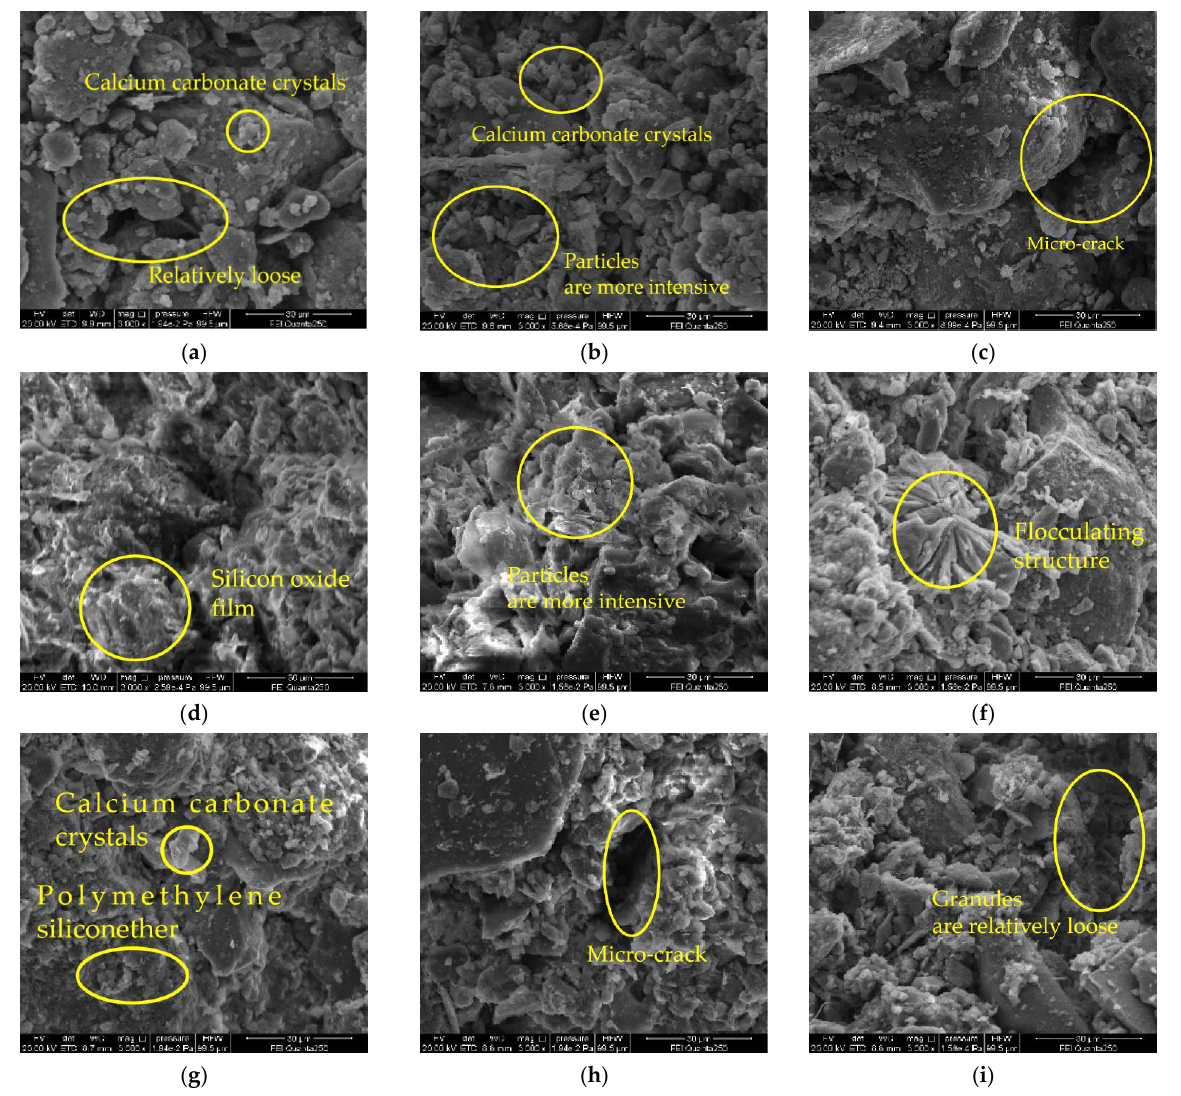
Figure 12. SEM pictures of different ratios of modified raw soil curing for 28 days: ( a ) 7% lime alone; ( b ) 15% lime alone; ( c ) 23% lime alone; ( d ) 0.5% mono-doped sodium methyl silicate; ( e ) 1.5% mono-doped sodium methyl silicate; ( f ) 3% mono-doped sodium methyl silicate; ( g ) 1.5% sodium methyl silicate +7% lime; ( h ) 1.5% sodium methyl silicate +15% lime; ( i ) 1.5% sodium methyl silicate +23% lime . Figure 12g – i are the SEM pictures of the multi-blended group after curing for 28 days.